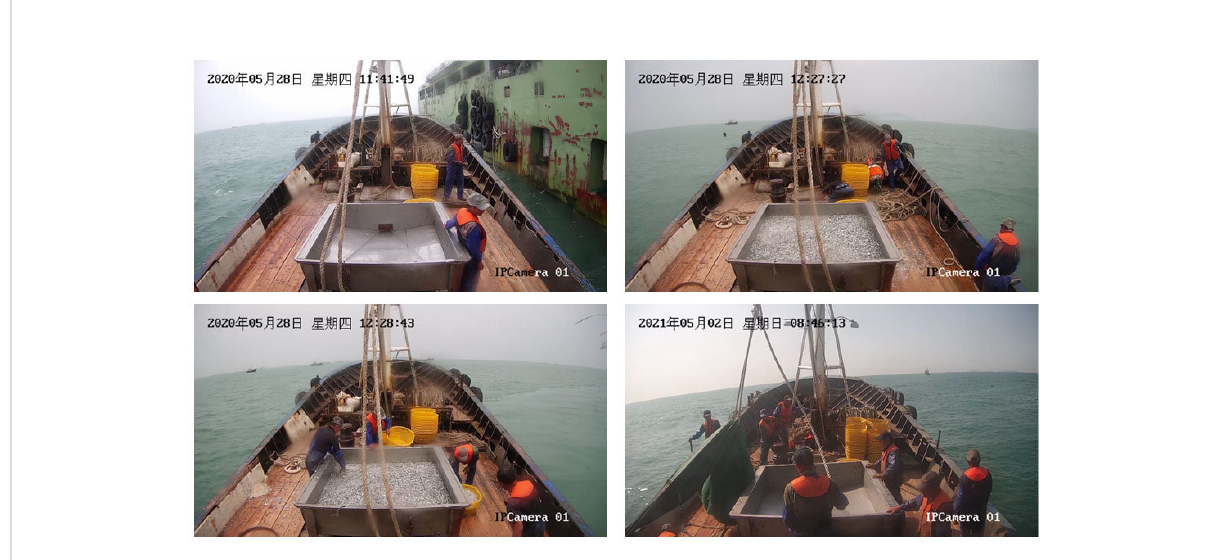
FIGURE 3 Original data graph.